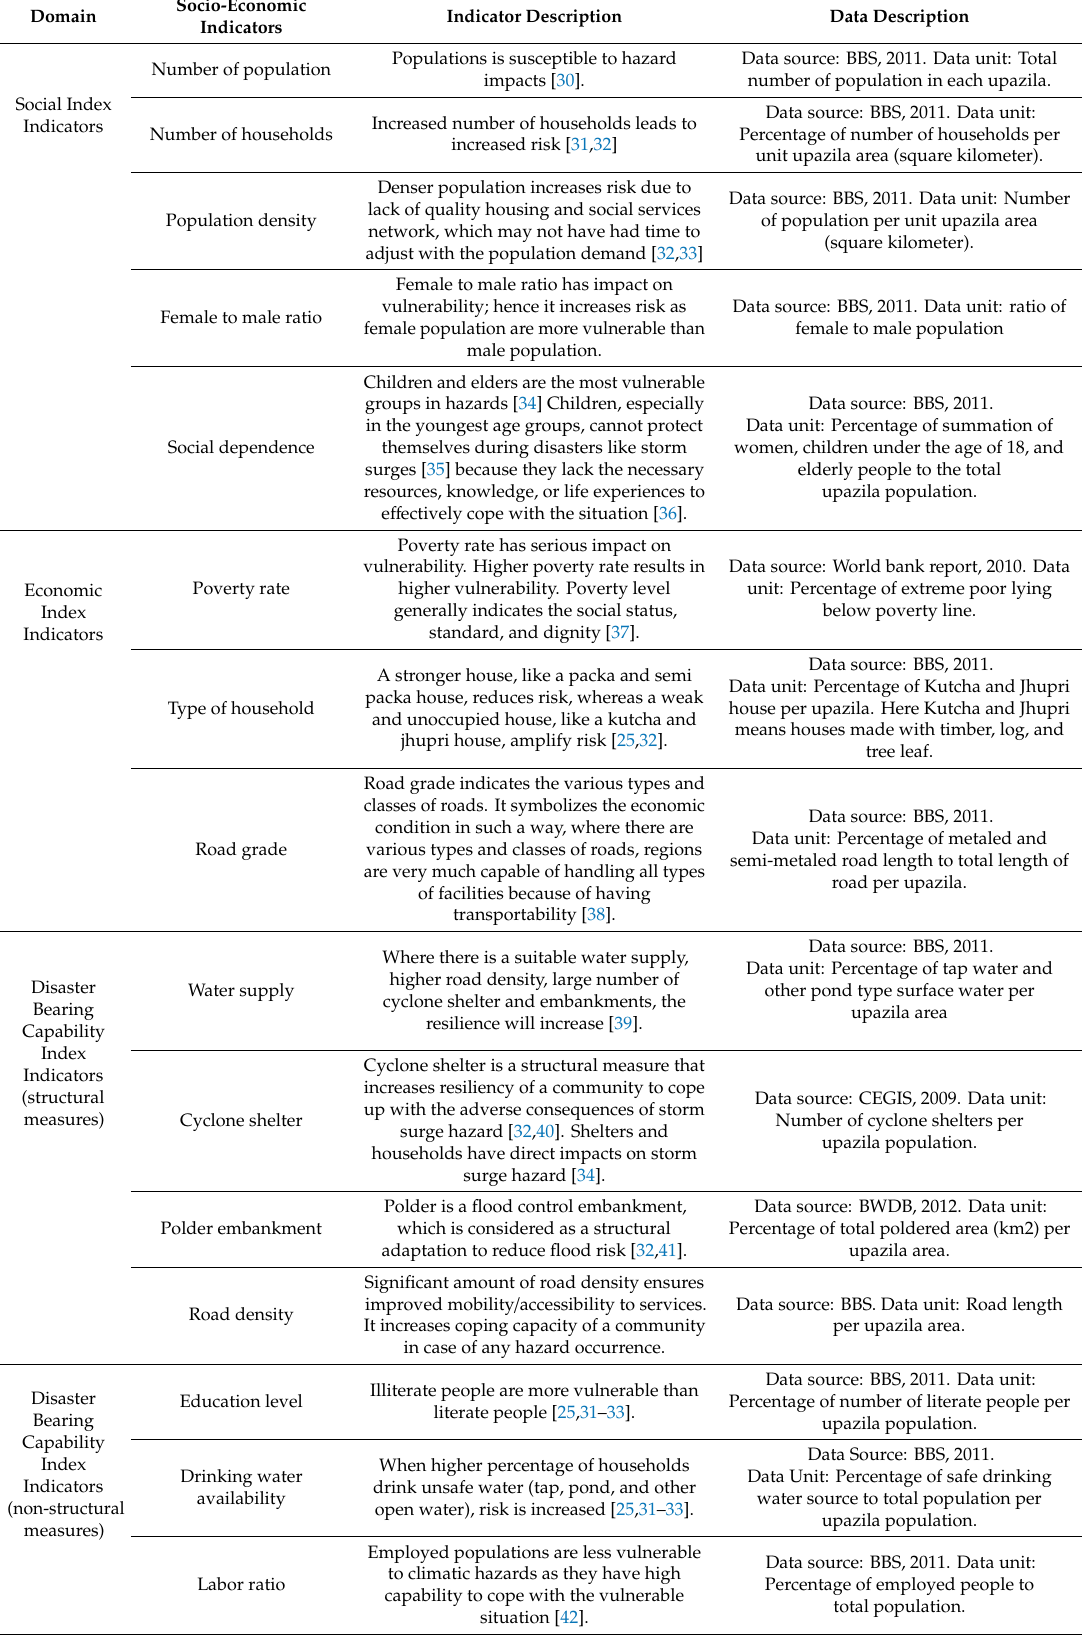
Table 1. Vulnerability